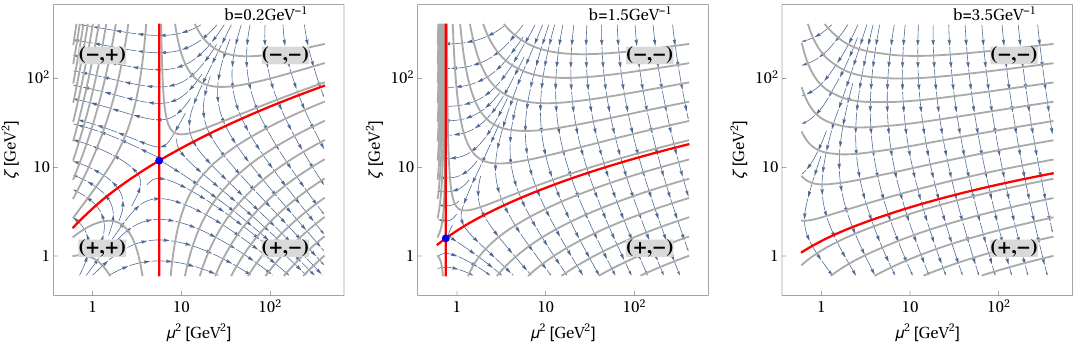
Figure 2 . The illustration of evolution (cid:13)ow (cid:12)eld E at di(cid:11)erent values of b . The blue point is the stable point. Gray curves are the equipotential lines (null-evolution curves). Red curves are special null-evolution curves. Special curves split the plane into quadrants with preserved sign of (cid:12)eld components, which is shown by bold font. At large b the stable point moves to the values of smaller (cid:22) , and crosses the Landau pole. The line of Landau pole in not presented and it is located at smaller values of (cid:22)